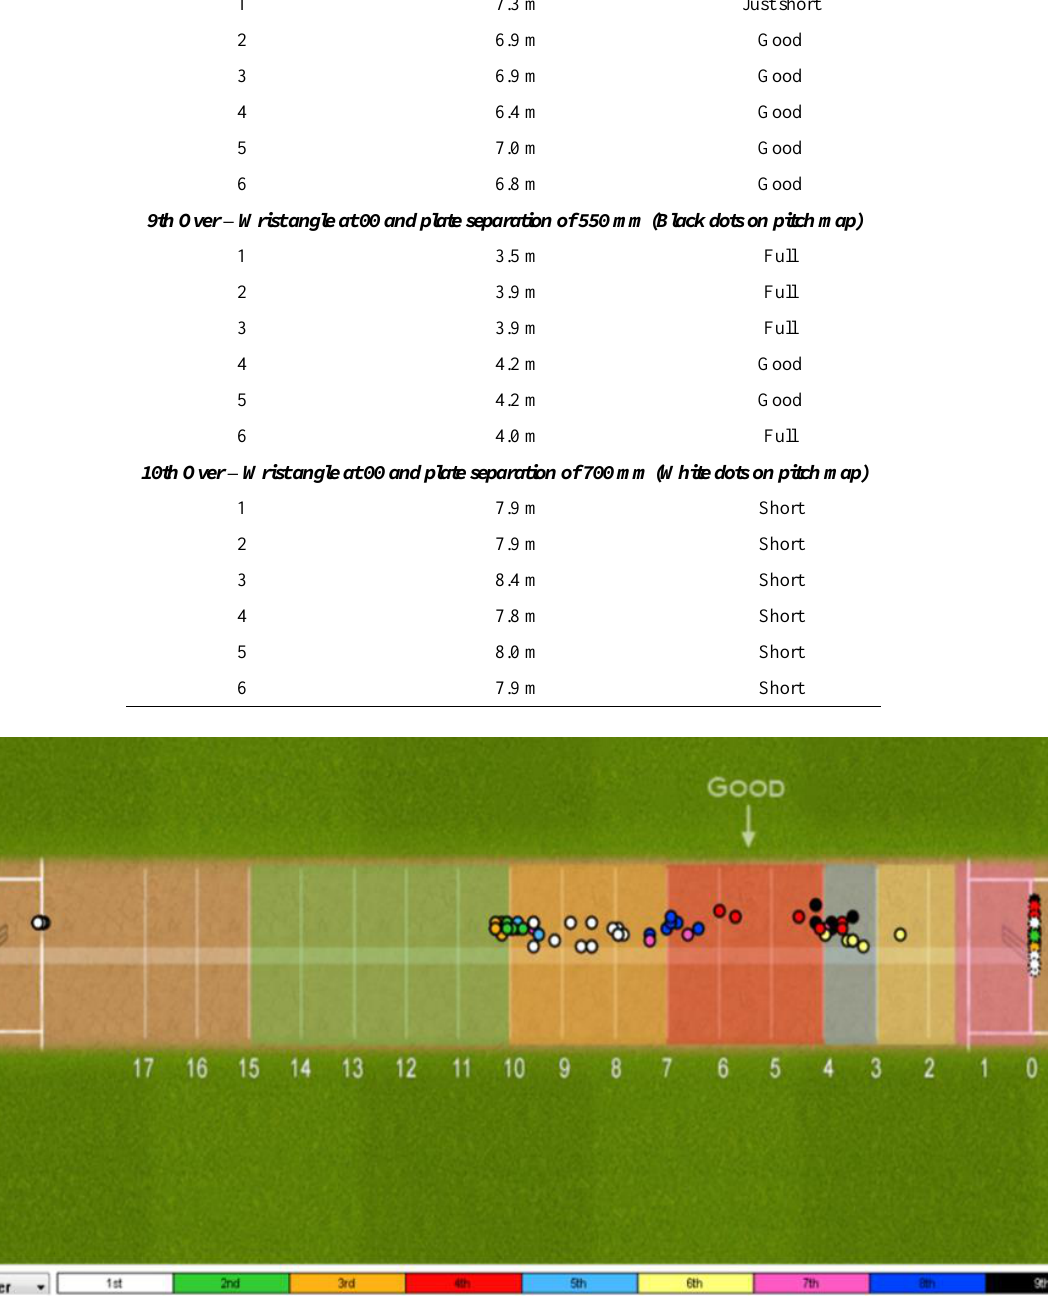
Figure 6. Pitch map of data collected for from Table 2.